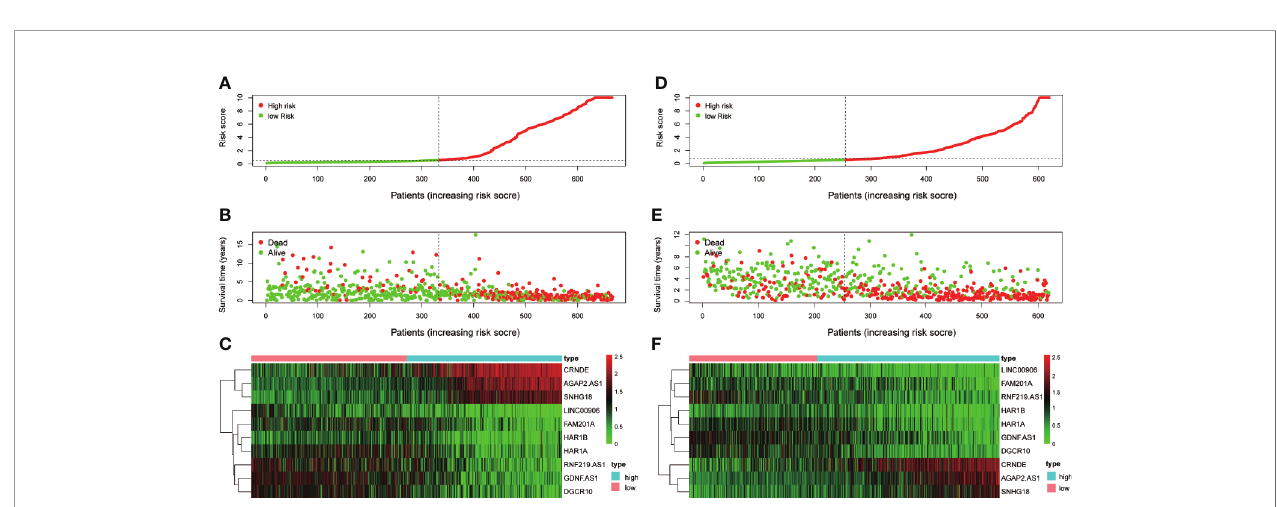
FIGURE 3 | Examination and validation prognostic models based on candidate lncRNAs signatures. (A) Risk score distribution in the TCGA database. (B) Survival status and time of glioma patients in the TCGA database. (C) The heatmap shows the expression pro fi les of 10 MES-related lncRNAs between the high- and low-risk groups in the TCGA database. (D) Risk score distribution validation in CGGA database. (E) Survival status and time of glioma patient validation in CGGA database. (F) The heatmap shows the expression pro fi les of 10 MES-related lncRNAs between the high- and low-risk groups validation in the CGGA